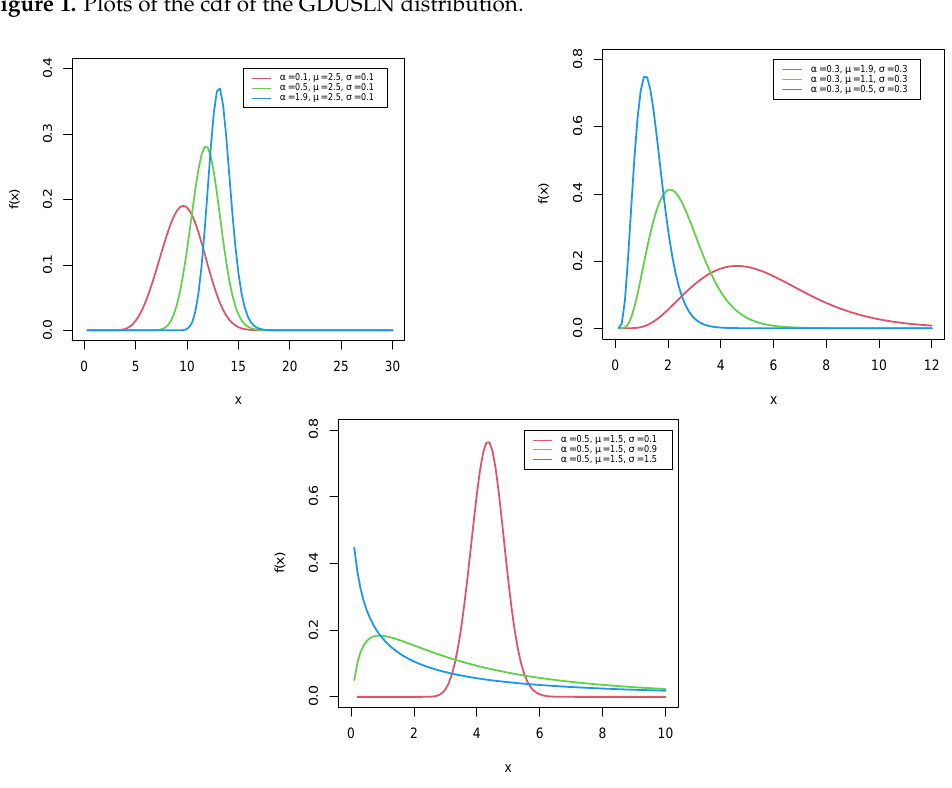
Figure 2. Plots of the pdf of the GDUSLN distribution. Furthermore, plots in Figure 3 refer to the shapes of the hazard rate